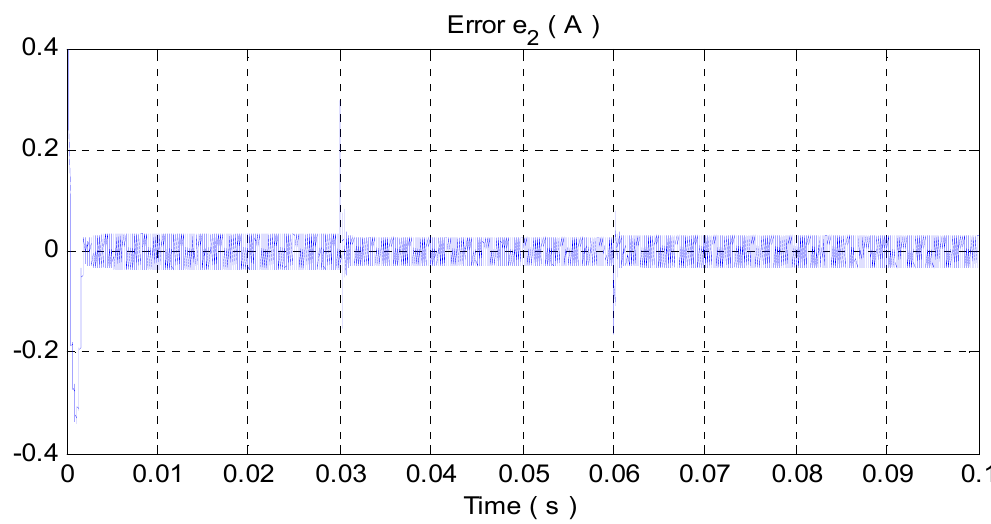
Figure 12. Capacitor voltage v c .